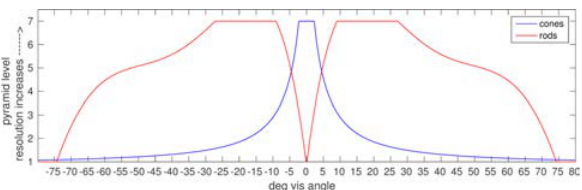
Figure A1. Plot showing the levels of visual pyramid sam- pled for each pixel depending on the distance from the center of the fovea and the type of distribution (rods or cones).